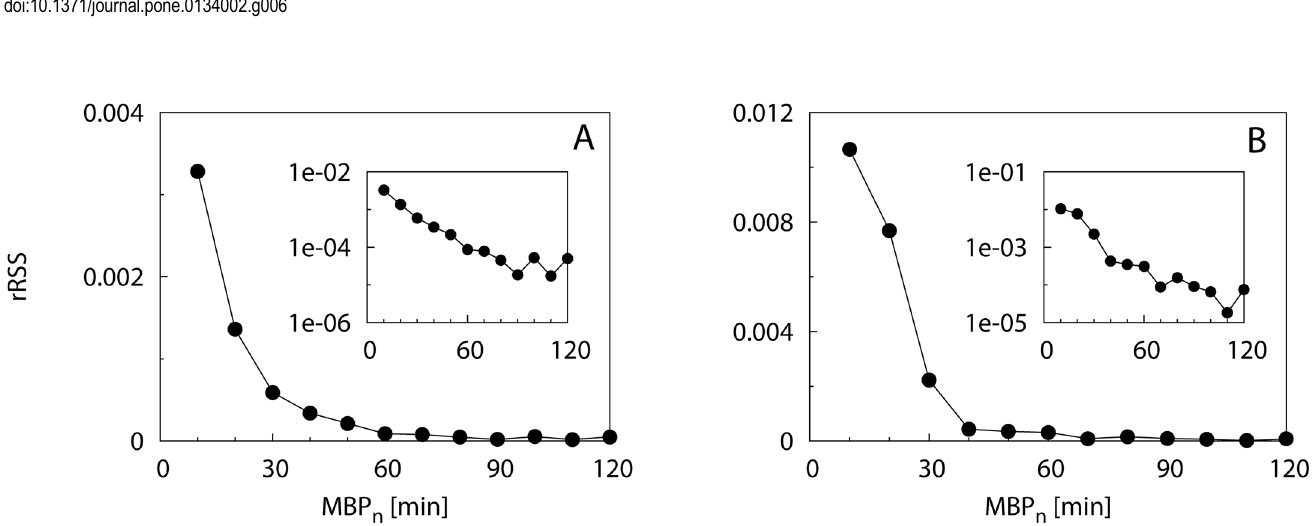
Fig 7. Field data: Renormalized sum of squared residuals at small timescales. The rSSR is calculated among pairs of survival curves ( S ( t MBP )) with Δ MBP = 10 min for bigeye scad (A) and yellowfin tuna (B). Insets: the same in semi-logarithmic scale. ( t MBP n + Δ MBP